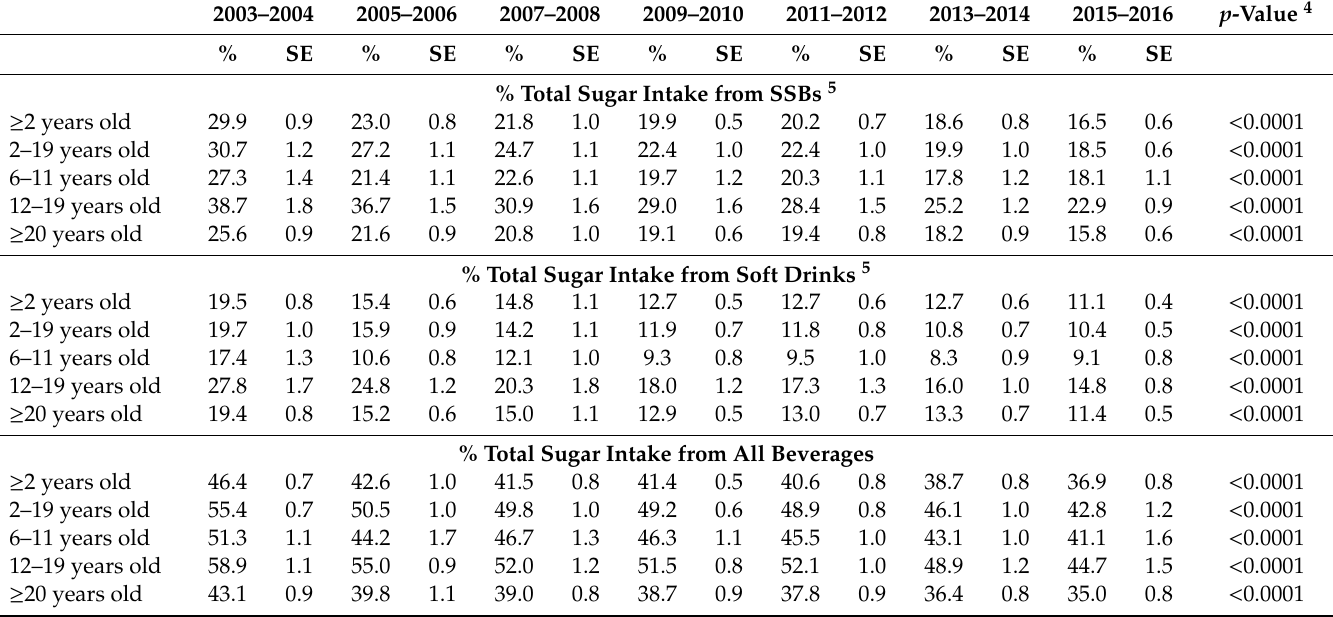
Table 2. Average Percentage of Total Sugar Intake over Time in the US by Age Groups 1–3 .